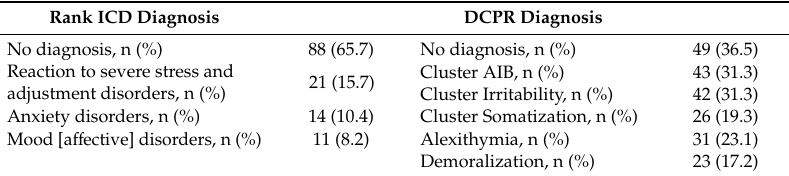
Table 3. Ranking order of DCPR and ICD diagnoses.